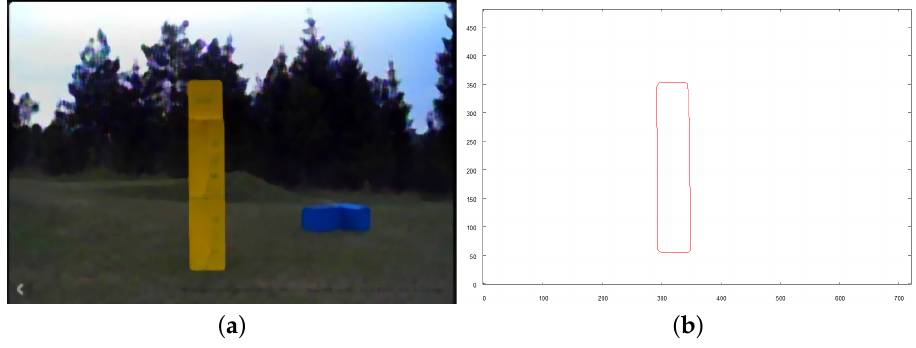
Figure 29. Image of RIGHT side of structure. ( a ) preprocessed image; ( b ) vectorized image.